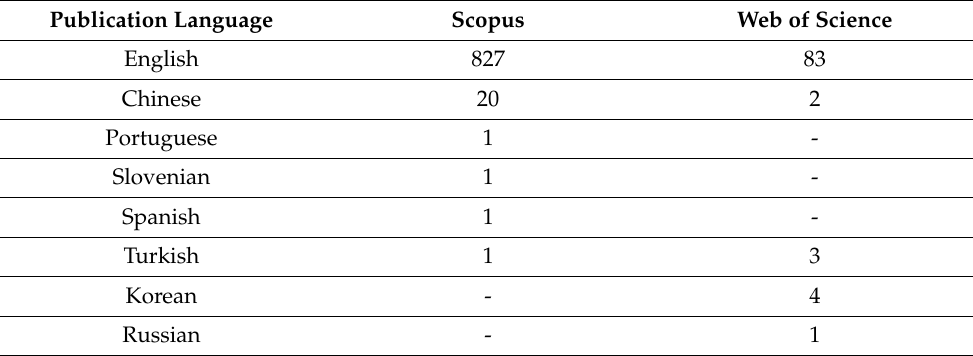
Table 5. Publications in different languages in the Scopus and Web of Science databases.